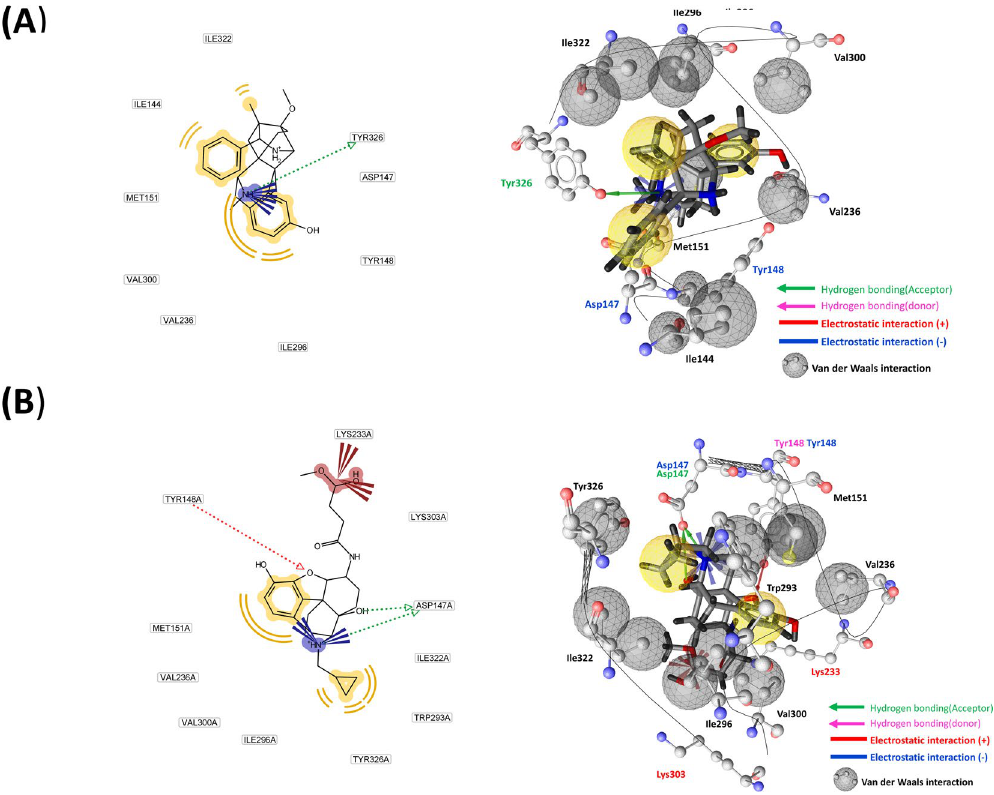
Figure 2. Binding modes (X-ray structures) of active/inactive MORs with BU72 and β -funaltrexamine. ( A ) Active MOR with BU72. ( B ) Inactive MOR with β